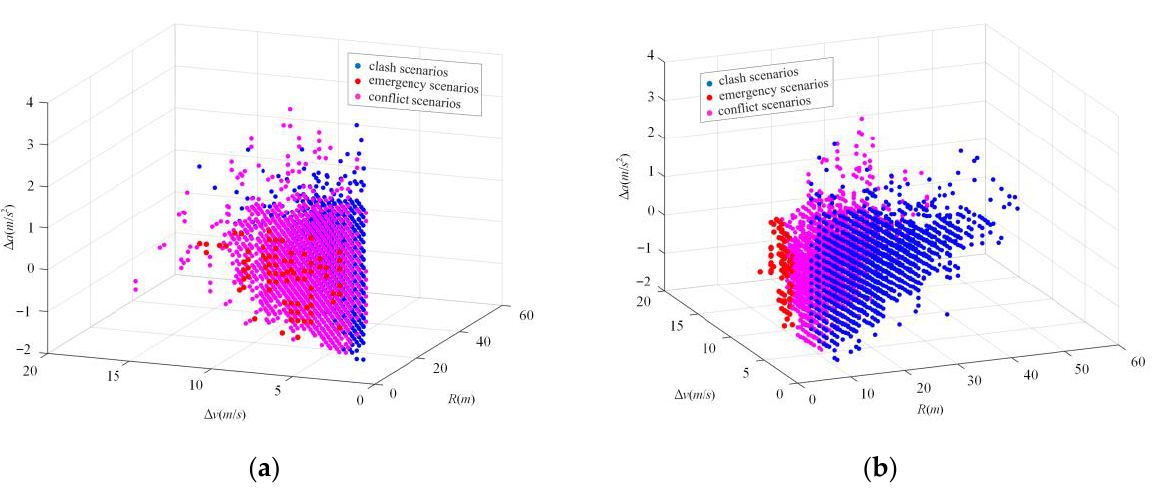
Figure 14. The distribution of critical scenarios in ISSD. ( a ) and ( b ) show the different perspectives of the distribution.